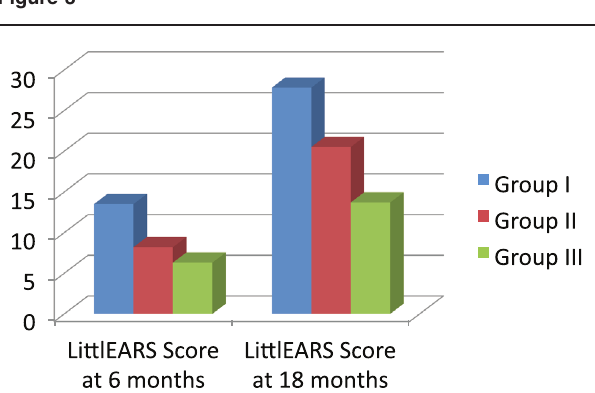
Individual comparisons between the 6- and the 18-month scores of LittlEARS Auditory Questionnaire for each